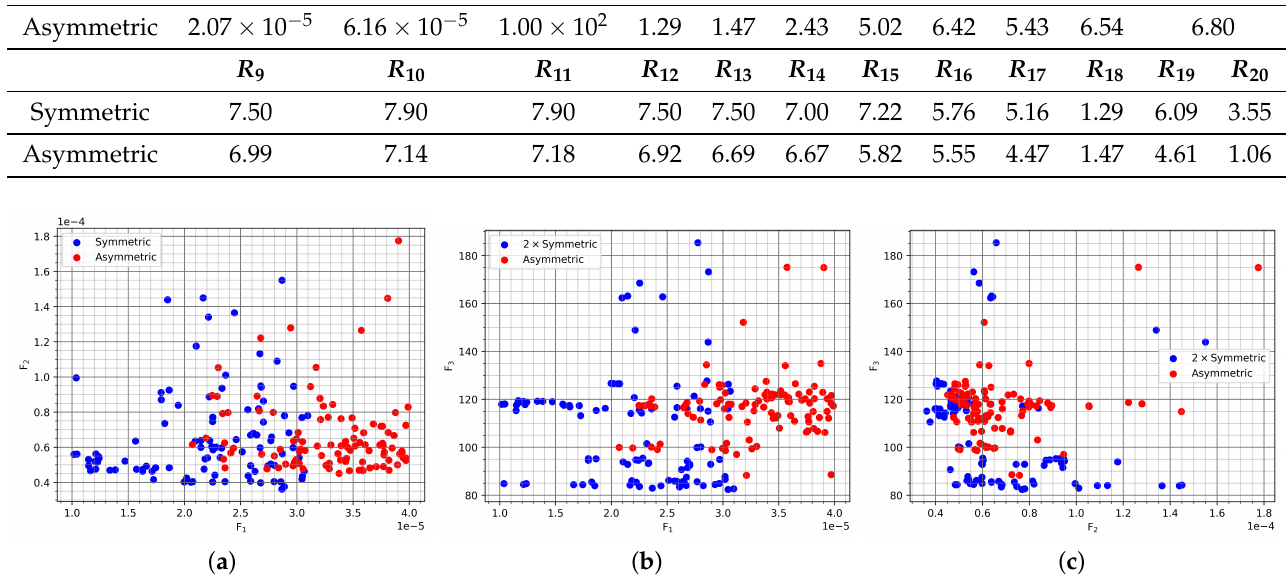
Figure 7. The image shows the first 100 individuals when they are sorted based on uniformity ( F 1 ) in case ( a ). The blue dots show the symmetric setups, while the asymmetric solutions are depicted in red. ( a ) The distribution of individuals on the